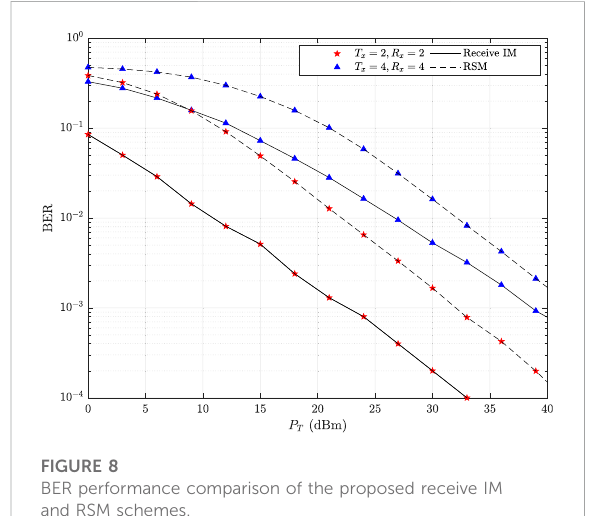
FIGURE 8 BER performance comparison of the proposed receive IM and RSM